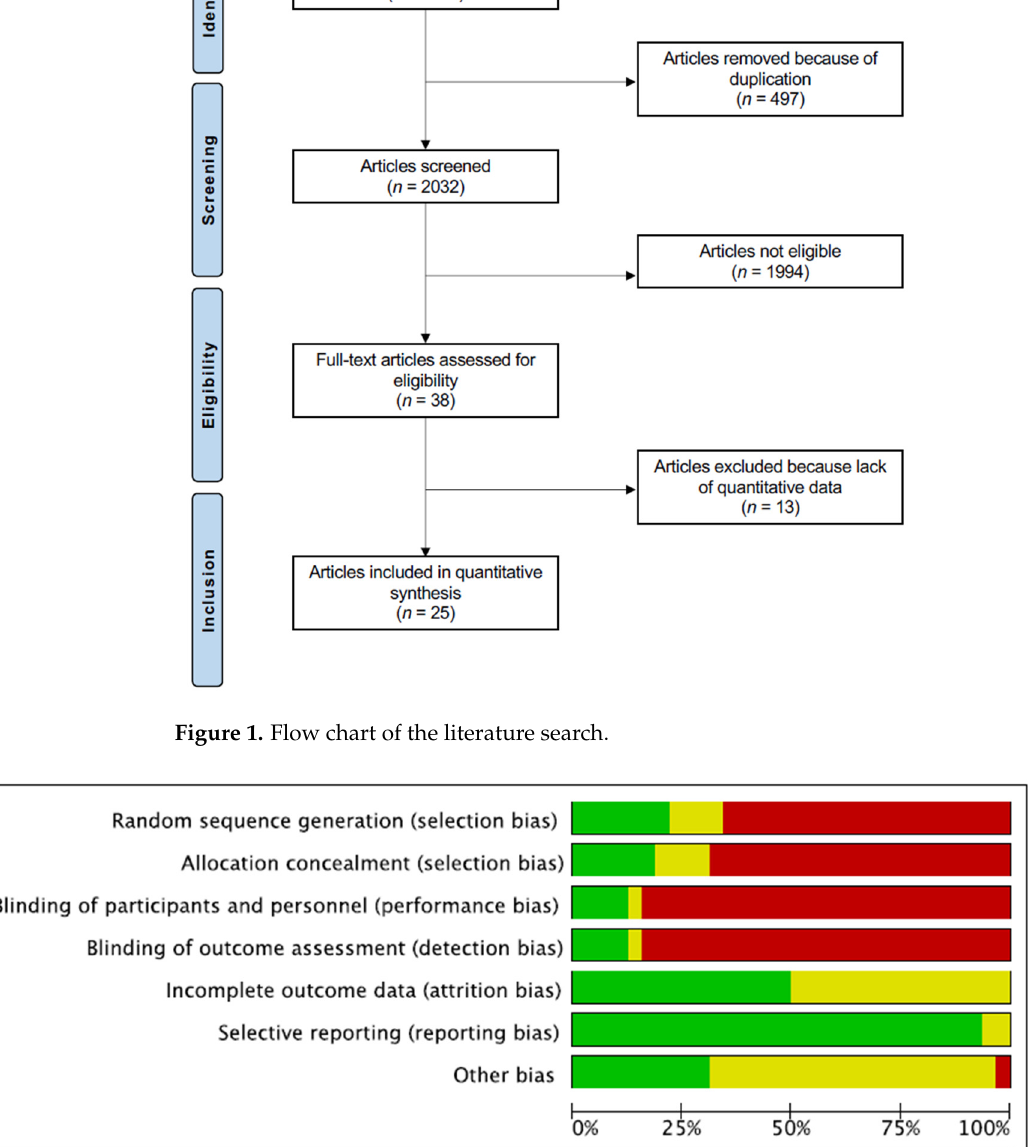
Figure 2. Risk of bias assessment. The risk of bias tool assessed the risk of bias (low, unclear, or high) per each risk of bias item presented as percentages across all included studies. The risk of selection bias evaluated the random sequence generation and the allocation concealment. The risk of detection bias assessed the blinding procedure during the outcome assessment. The risk of attrition bias refers to incomplete outcome data during study enrollment or analysis. The risk of reporting bias analyses the selective publication of results based on their statistical or clinical relevance. If